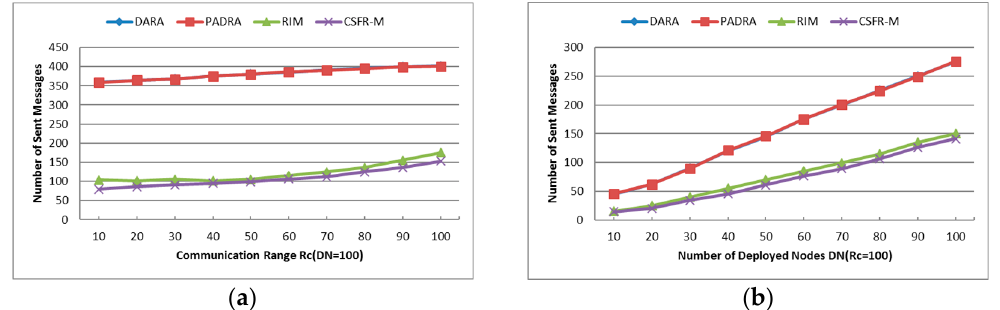
Figure 13. ( a ) SN with different (cid:1844) (cid:3030) ; and ( b ) SN with different DN.